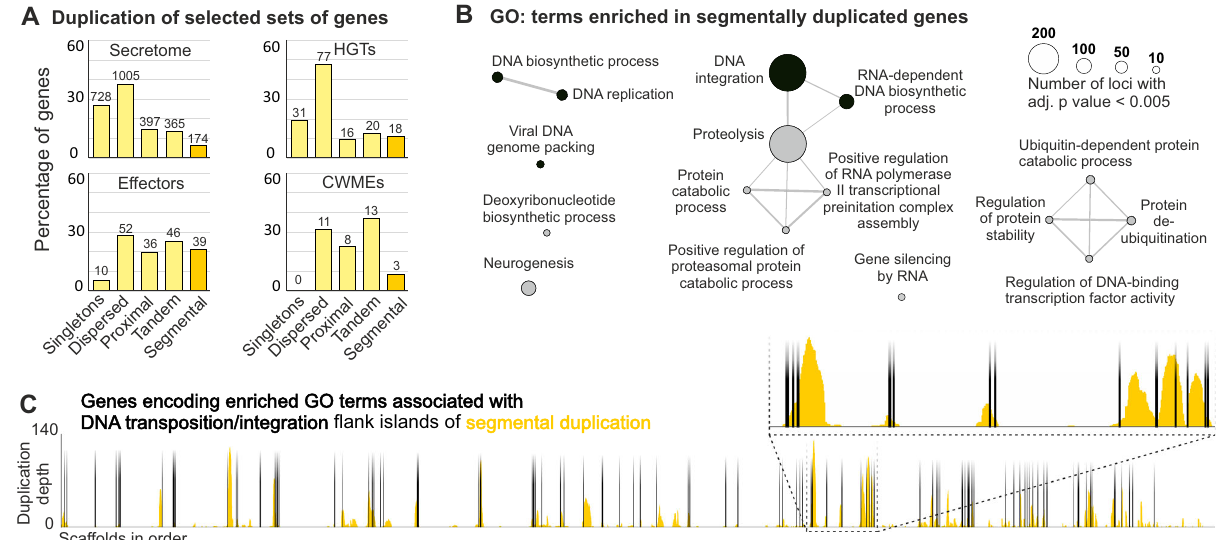
B GO enrichment of segmentally duplicated genes in H. schachtii . C Orange bars indicatetheduplicationdepthofsegmentallyduplicatedgenesacrossthegenome. Black bars (shading is vertical only and artistic, and does not carry meaning) indi- cate the position of genes encoding enriched GO terms associated with DNA transposition/integration in segmental